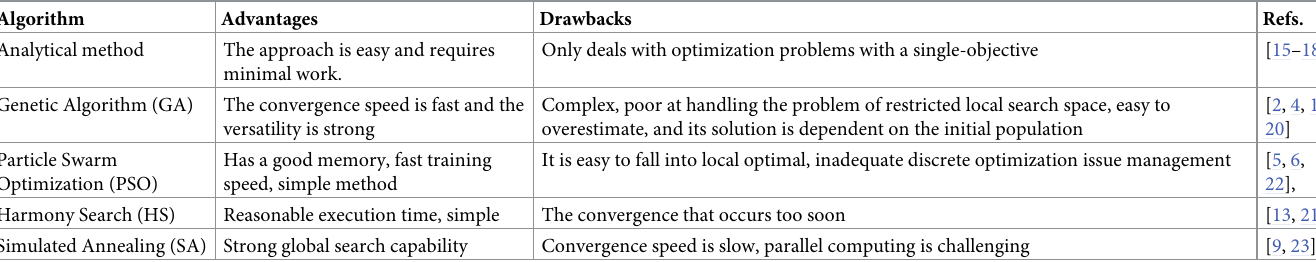
Table 2. Advantages and drawbacks of various algorithms in grounding design